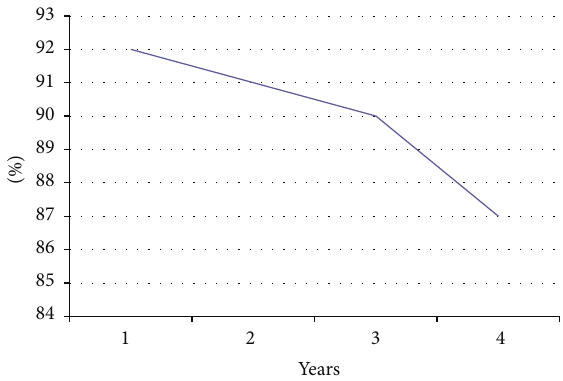
Figure 5: Diagram of success rate of the follow-up per